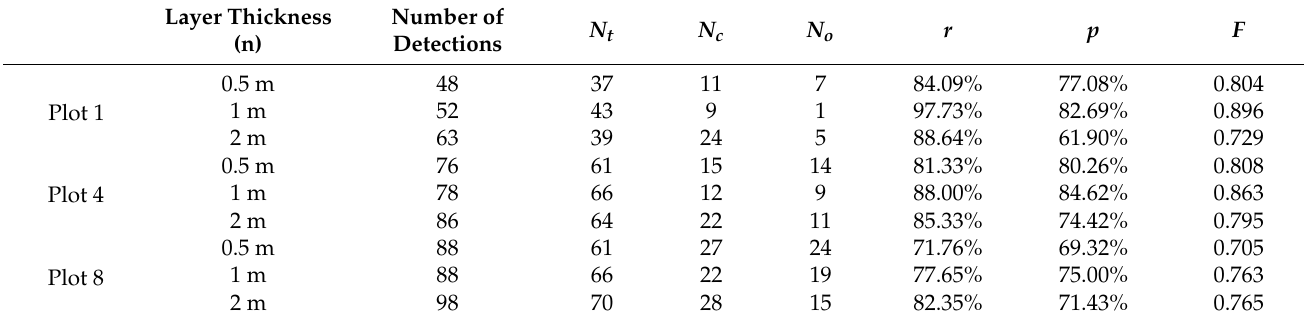
Table 4. Sensitivity analysis of the LS